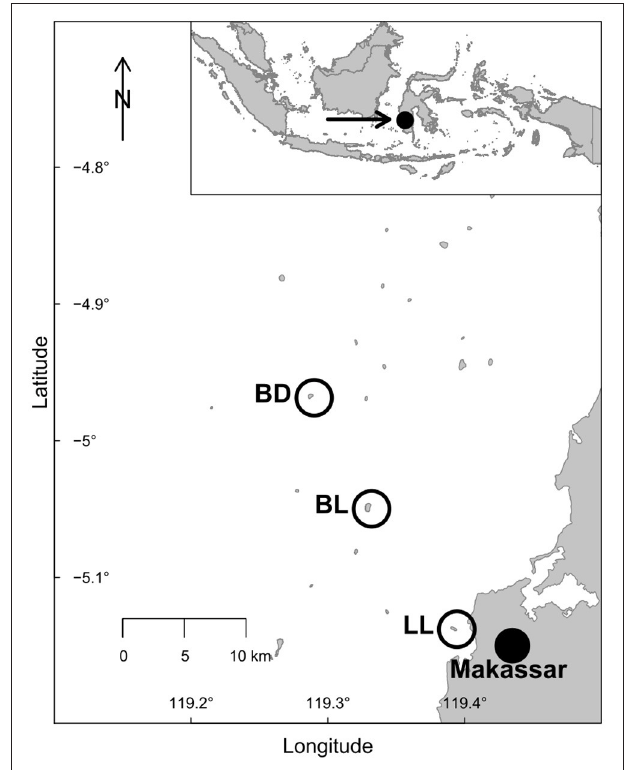
FIGURE 1 | Map of the study area in the Spermonde Archipelago, southern Sulawesi, Indonesia. The three small islands investigated are marked on the map. Inshore Lae-Lae (LL), near-shore Barrang Lompo (BL), and mid-shelf Badi